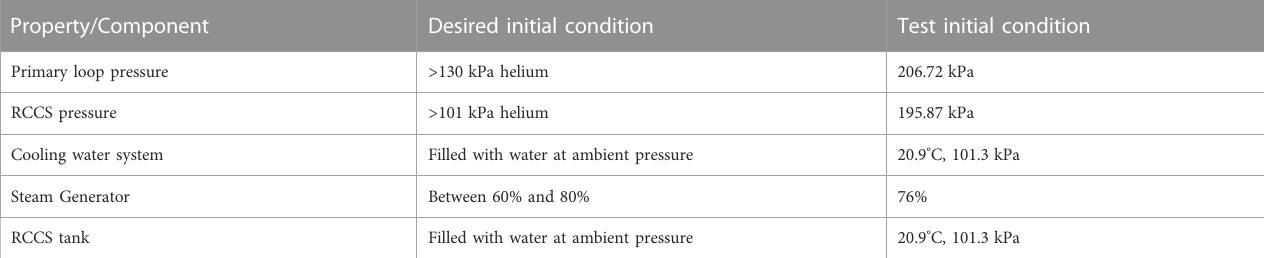
TABLE 4 PG-27 test initial conditions.